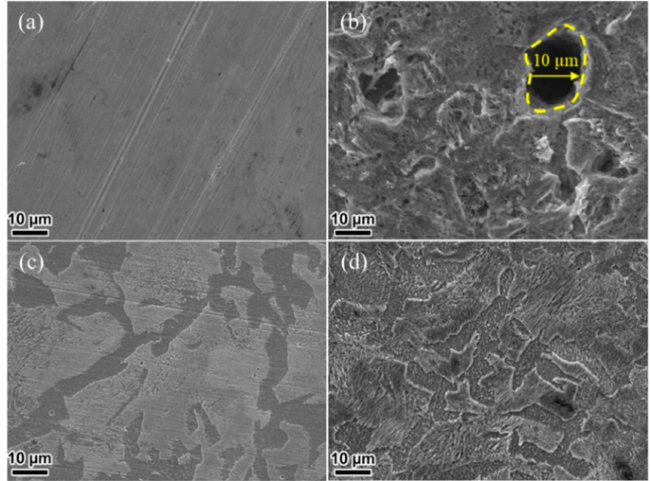
Figure 5. SEM images of ( a ) fresh carbon steel and carbon steel immersed in 1 M HCl solution ( b ) without and with 2 mM ( c ) AIA or ( d )